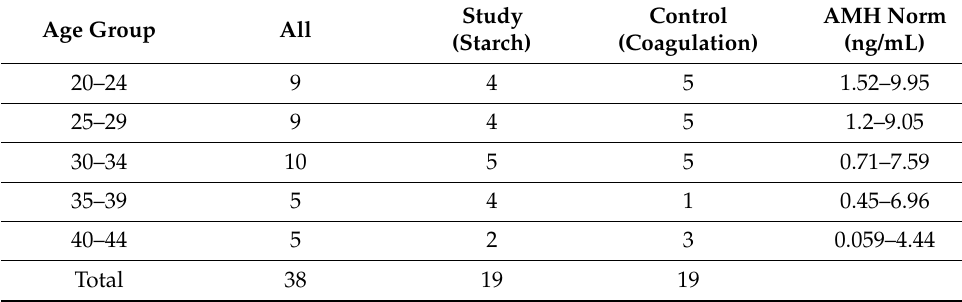
Table 3. Distribution of analyzed patients and norms within age